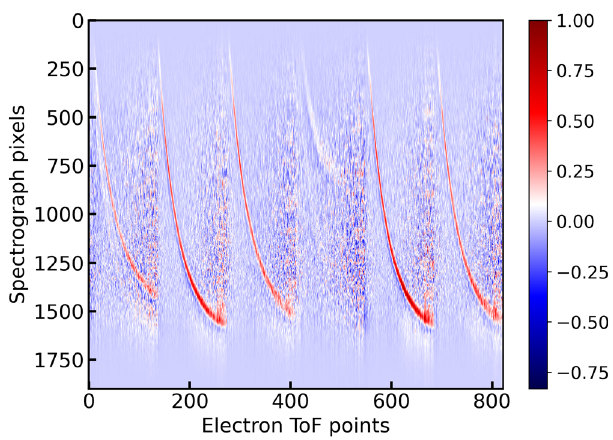
Fig. 2 The response matrix for the photoelectron spectrometer (PES) array. The response matrix, R (Eqn. (2)), was computed with data from six electron time-of- fl ight spectrometers (eToFs), the corresponding photon spectra from the variable-line spacing (VLS) spectrometer and all the available shots N = 15,337. Each of the eToFs produces a distinct curve (red line) mapping the time-of- fl ight to the photon energy measured by the VLS spectrometer. The intensity at speci fi c photon energy, i.e., spectrograph pixel, is comprised of contributions (positive and negative) from each of the six